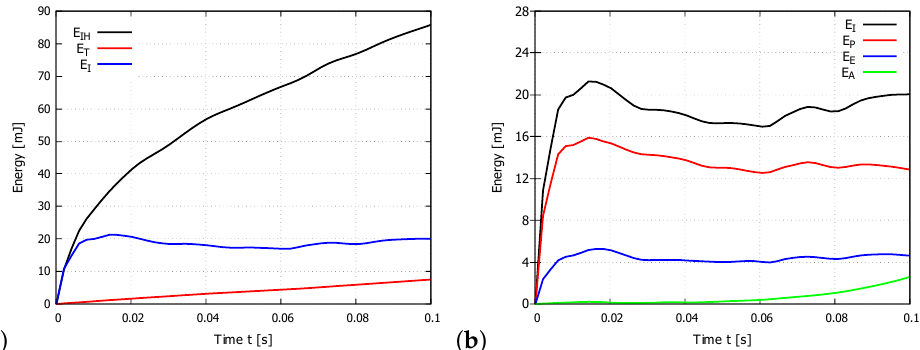
Figure 8. Graphs of energies in the FE model during cutting simulation (density 40 PCF): ( a ) internal heat energy E IHE , total energy E T , and total strain energy E EI ; ( b ) total strain energy E I , inelastic dissipated energy E P , elastic strain energy E E , and artificial strain energy E A .